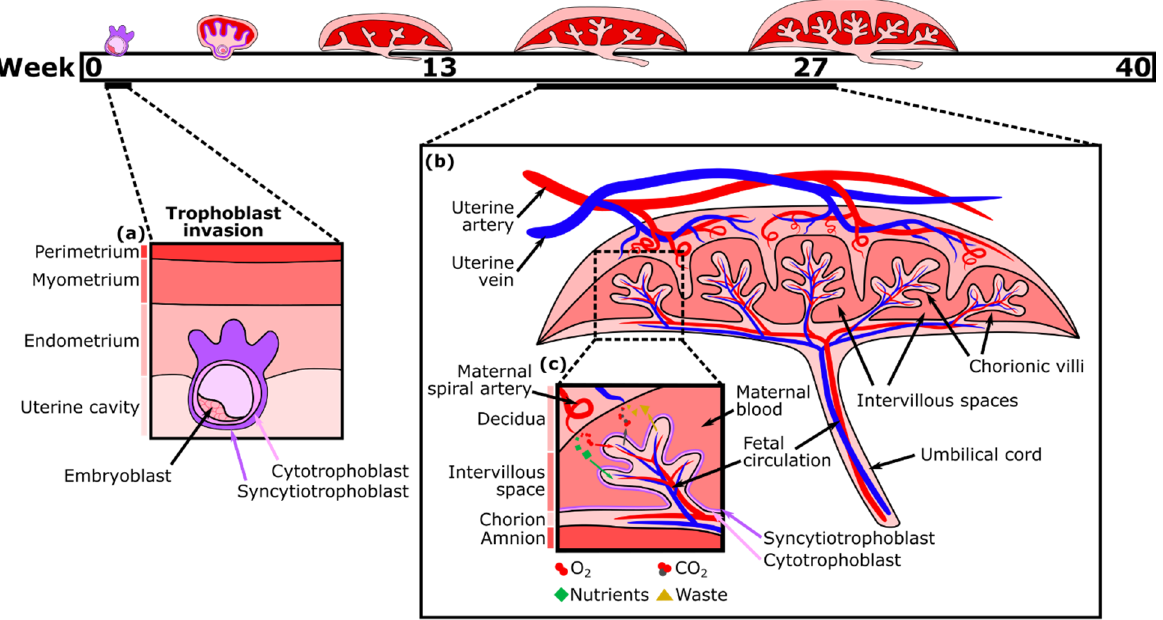
Figure 1. Placental development timeline, trophoblast invasion, and mature placental structure. ( a ) Diagram of trophoblast invasion around day 9, wherein the syncytiotrophoblast layer surrounding the embryoblast begins to invade the endome- trium. ( b ) Mature placental structure showing maternal and fetal vasculature. ( c ) Focus on exchange of nutrients between open maternal blood and closed fetal circulation across the two trophoblastic layers.